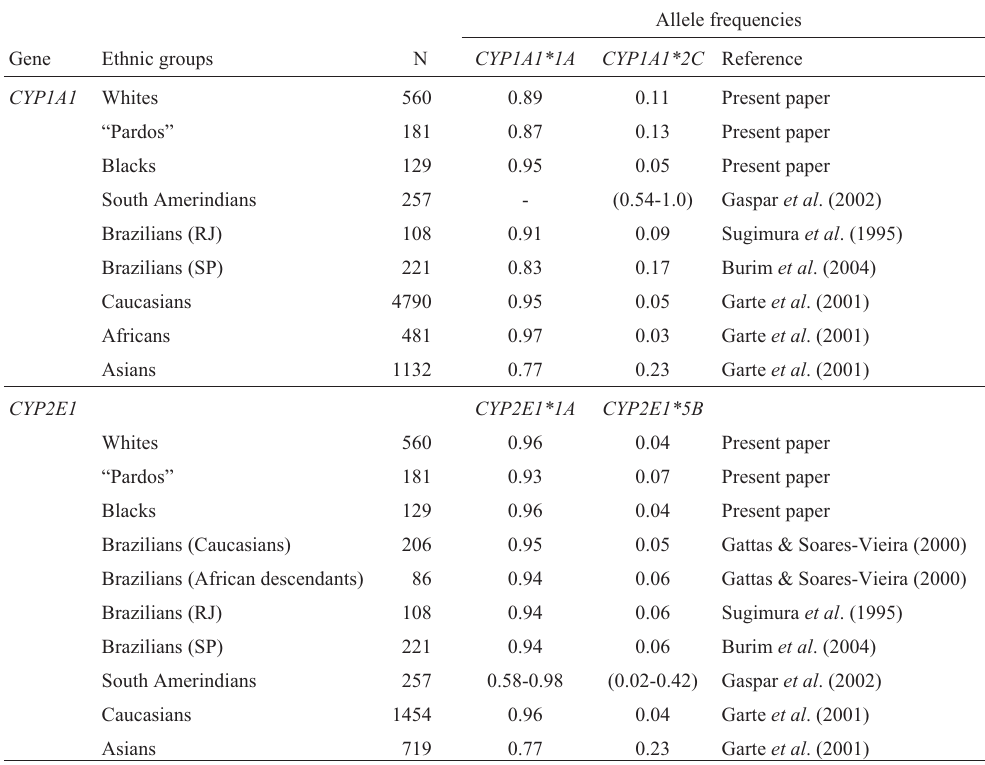
Allele frequencies